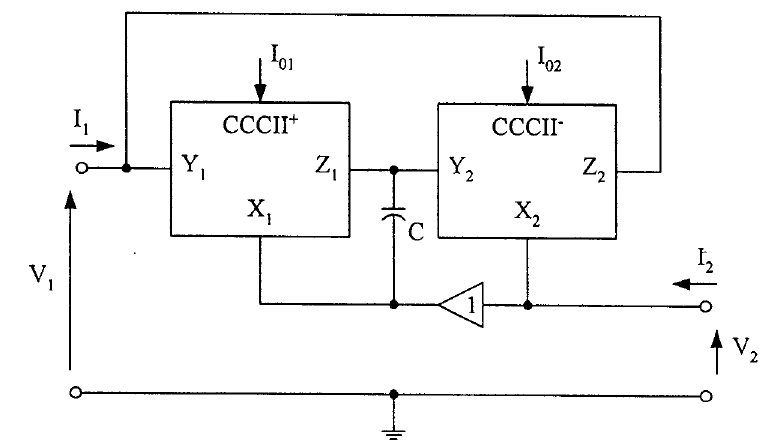
FIGURE 1 Proposed ideal floating inductance simulator (FIS).